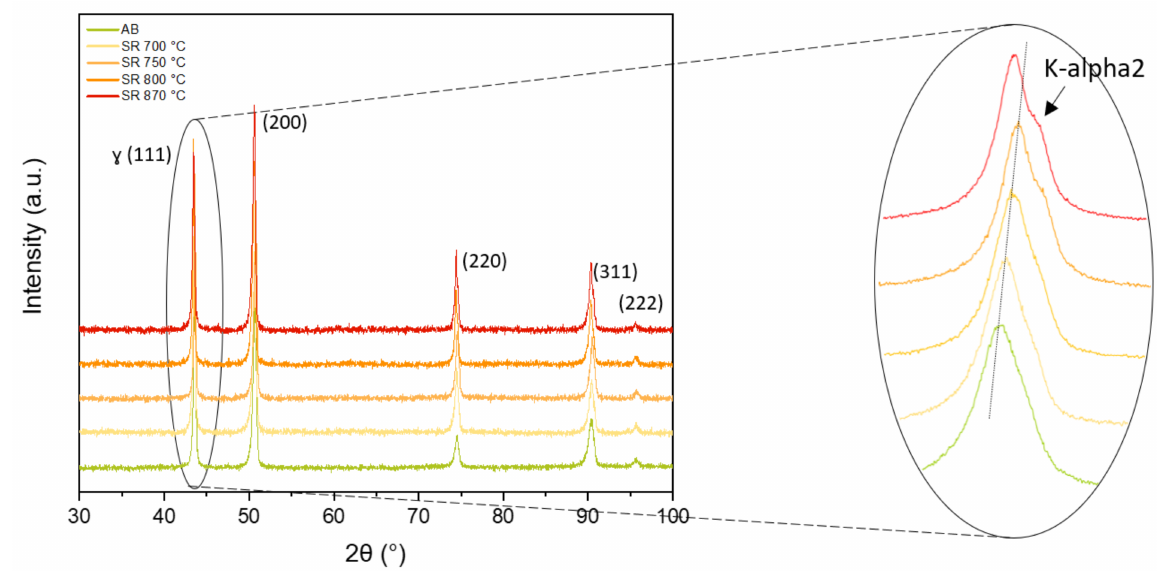
Figure 8. The XRD patterns of the as-built and stress-relieved IN625